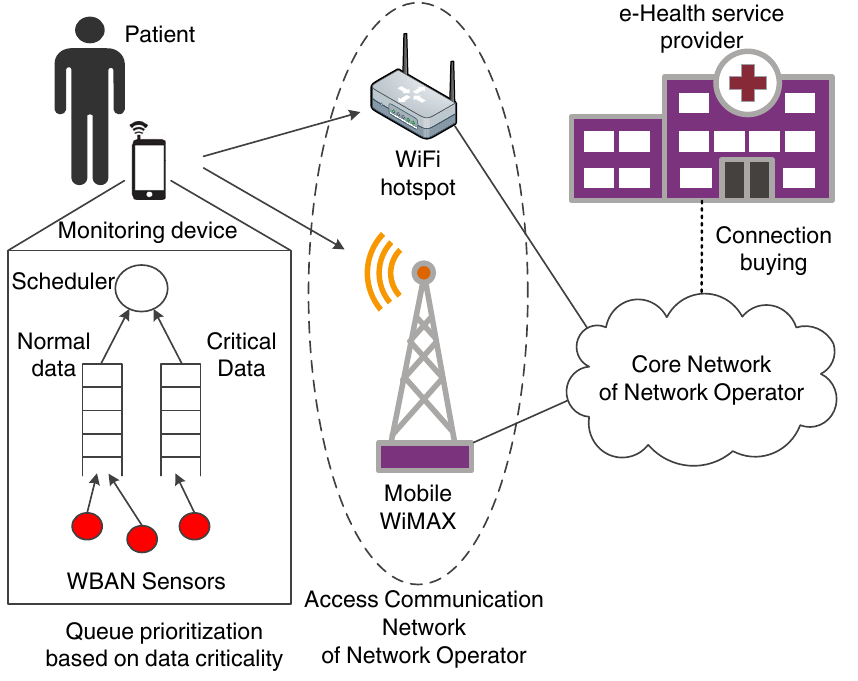
Figure 5. Architecture of remote patient monitoring system for WiFi/WiMAX heterogeneous